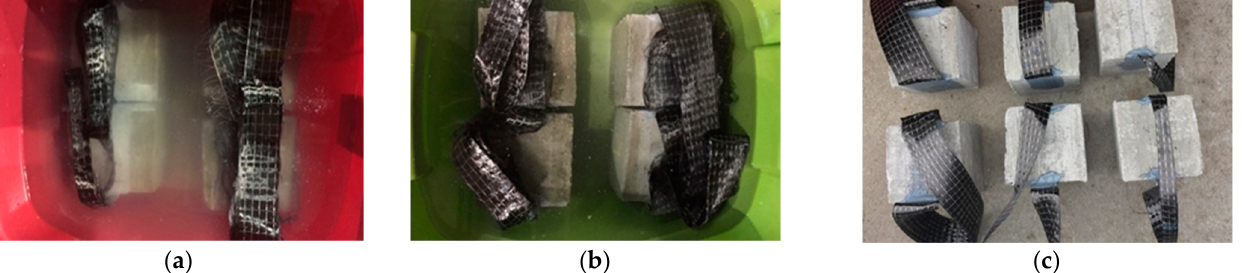
( b ) Figure 3. Outdoor environmental changes. ( a ) Average temperature and precipitation. ( b ) Humidity data. 2.1.3. Test Setup An MTS loading machine was used to conduct the double-face shear-type pull-off shearing test [22]. This kind of loading was used to eliminate the action of the load’s eccentricity on the CFRP–concrete interface [20]. Figure 4 displays the details of the test setup, which consists of a cylindrical roller with a diameter of 150 mm (6 in.) to match the width of the concrete prisms to apply a pure shear along with the interface between the CFRP and concrete. A thick steel plate of 25 mm (1 in.) thickness with four anchor bolts was used to fix the concrete prisms in their position during the test. The CFRP strip was wrapped around the cylindrical roller, and the two ends were bonded to the sides of the concrete prism by using epoxy resin. The steel roller was directly attached to the load cell by using mechanical fasteners (see Figure 4).